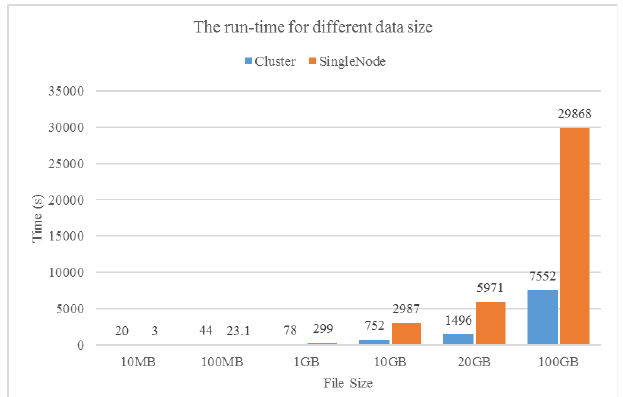
Figure 5 . Average run-time for two